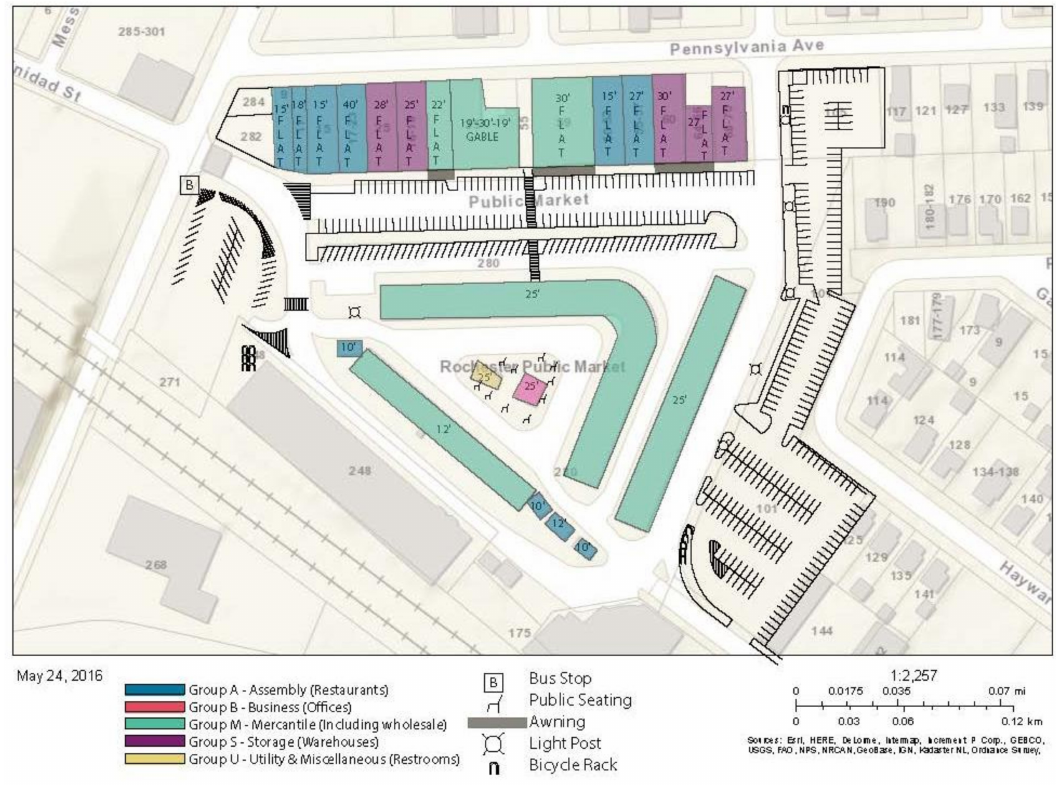
Figure 6. Rochester Public Market urban form and pattern map (By